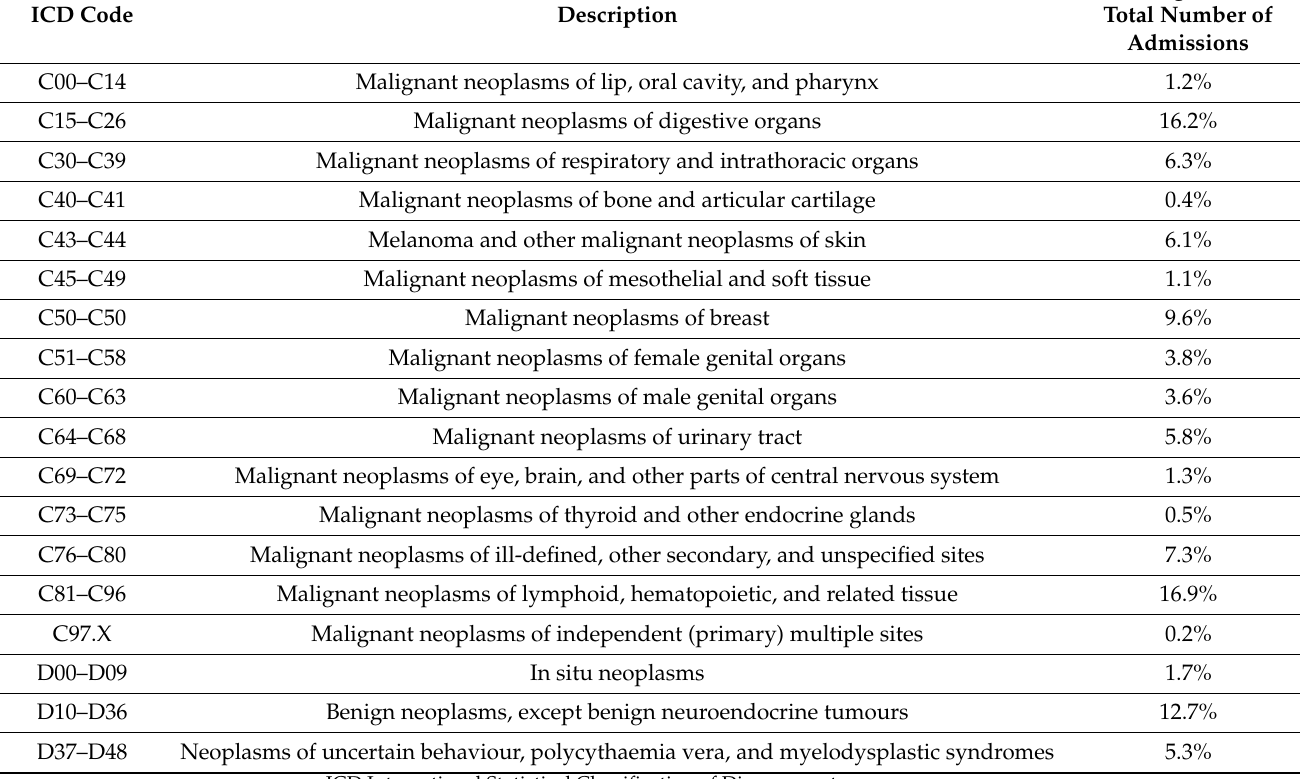
Table 1. Percentage of neoplasm-related hospital admissions from total number of admissions per ICD